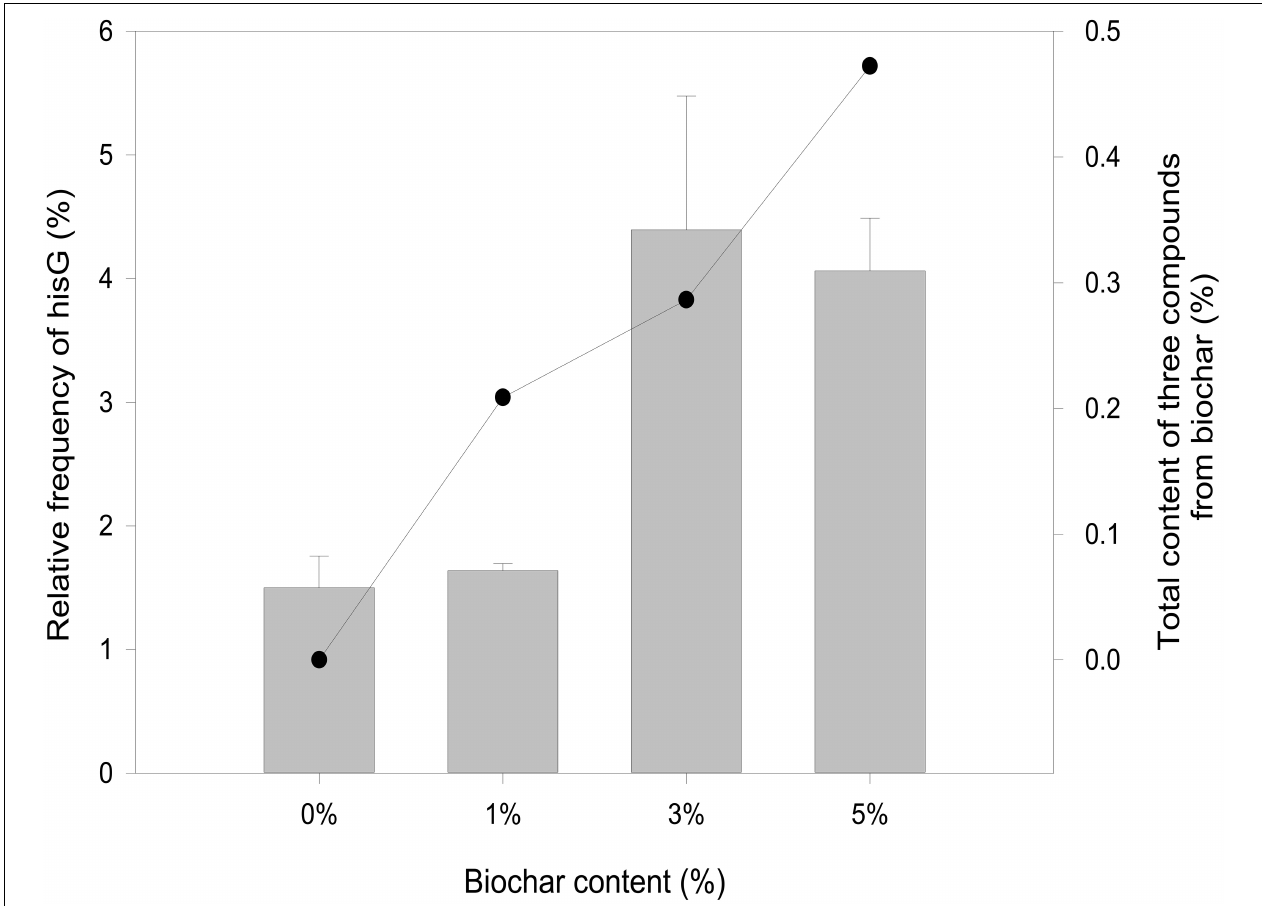
FIGURE 4 | Quantitative RT-PCR analysis of his G gene expression from 0, 1, 3, and 5% biochar treatment for 48 h (bar graph). The sum of eugenol, salicyl alcohol, and cyclopentane from biochar over a 48-h period.